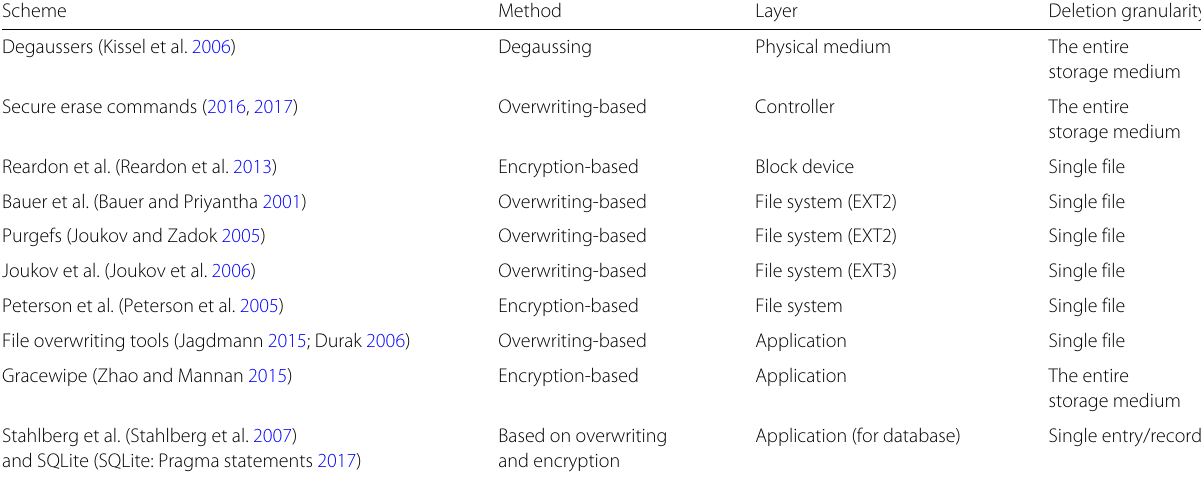
Table 3 Comparison of features offered by different secure deletion approaches for HDDs-based storage systems